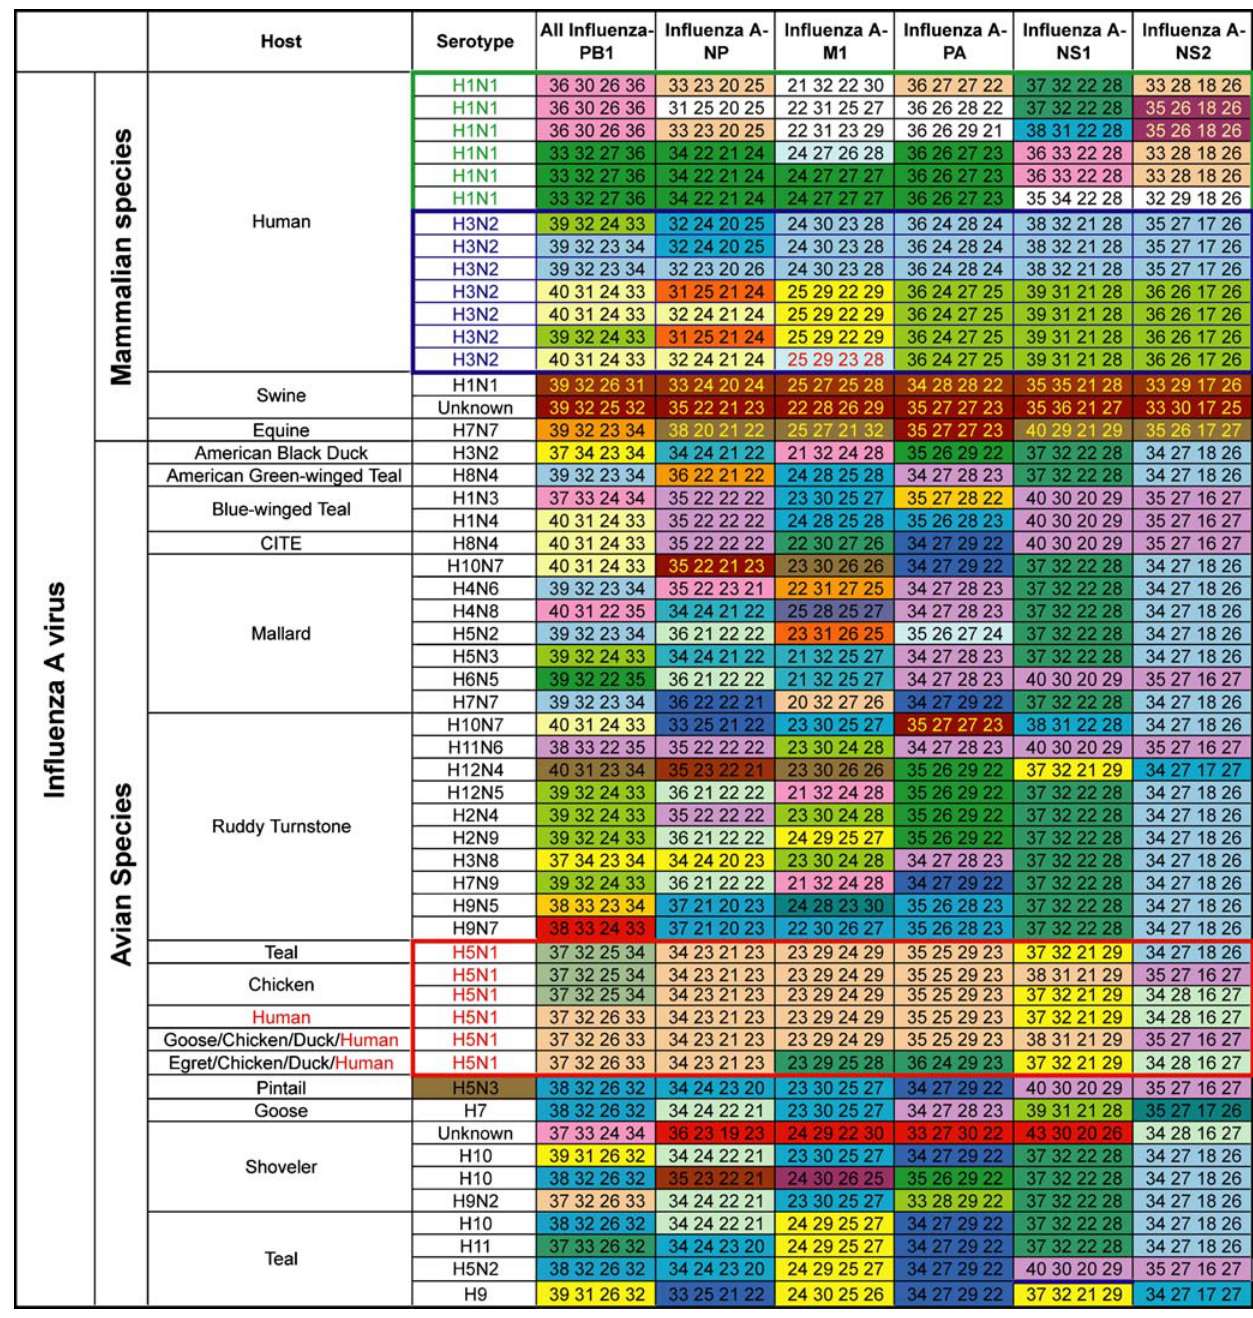
Figure 1. Detection and characterization of important human and avian influenza virus subtypes. Base composition signatures are shown in A, G, C, T order. Identical base compositions within a column are the same color. Base compositions represented only once are shown in white. Base compositions from human H1N1, human H3N2 and avian/human H5N1 isolates (in green, blue and red boxes, respectively) are included in Figure 2.